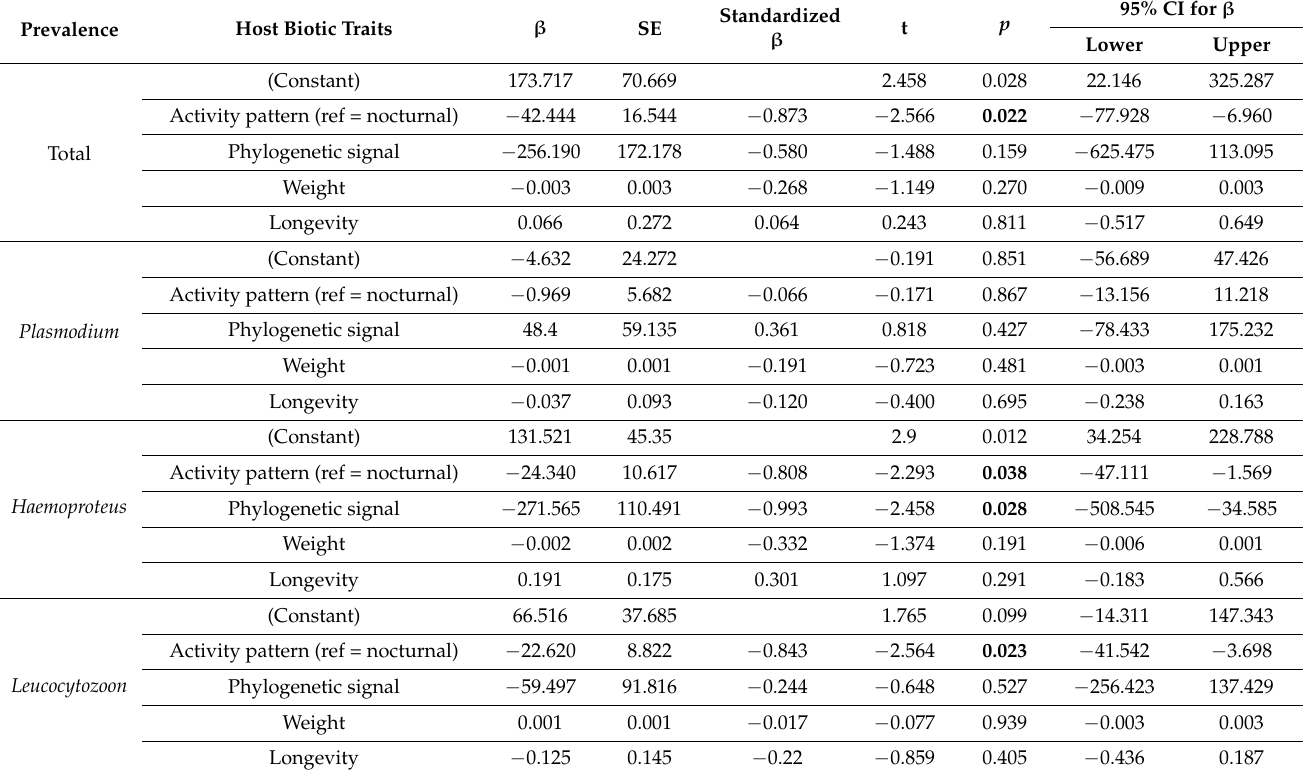
Table 1. Differences in haemosporidian prevalence between diurnal and nocturnal